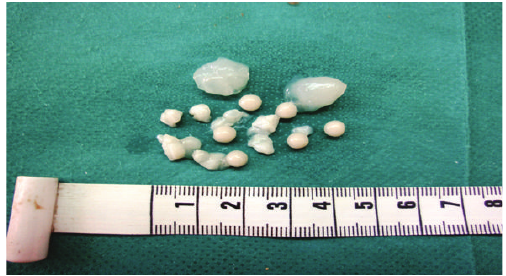
Figure 1: Macroscopic appearance of the extruded mucin and globules.